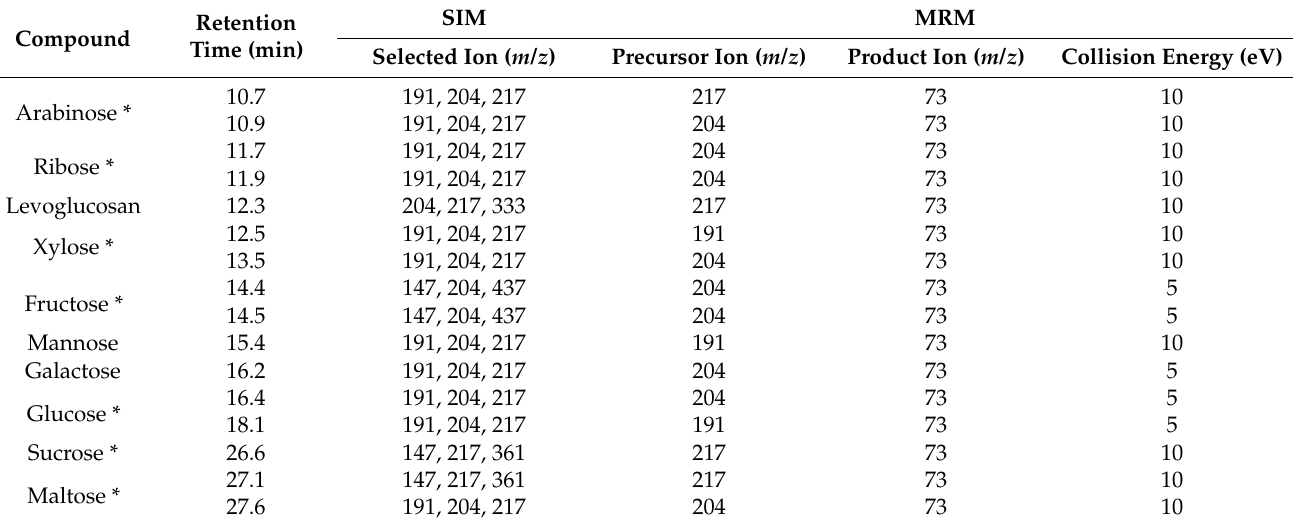
Table 4. Selected ion monitoring (SIM) conditions used in MS analysis and multiple reaction monitoring (MRM) conditions used in MS/MS analysis of target